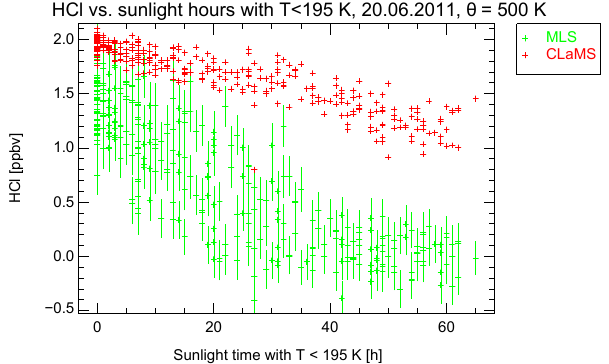
Figure 8. MLS observations of HCl mixing ratio that are also dis- played in Fig. 7 plotted against sunlight time with temperatures be- low 195K derived from the backward trajectories (green symbols) and the corresponding CLaMS results (red symbols).